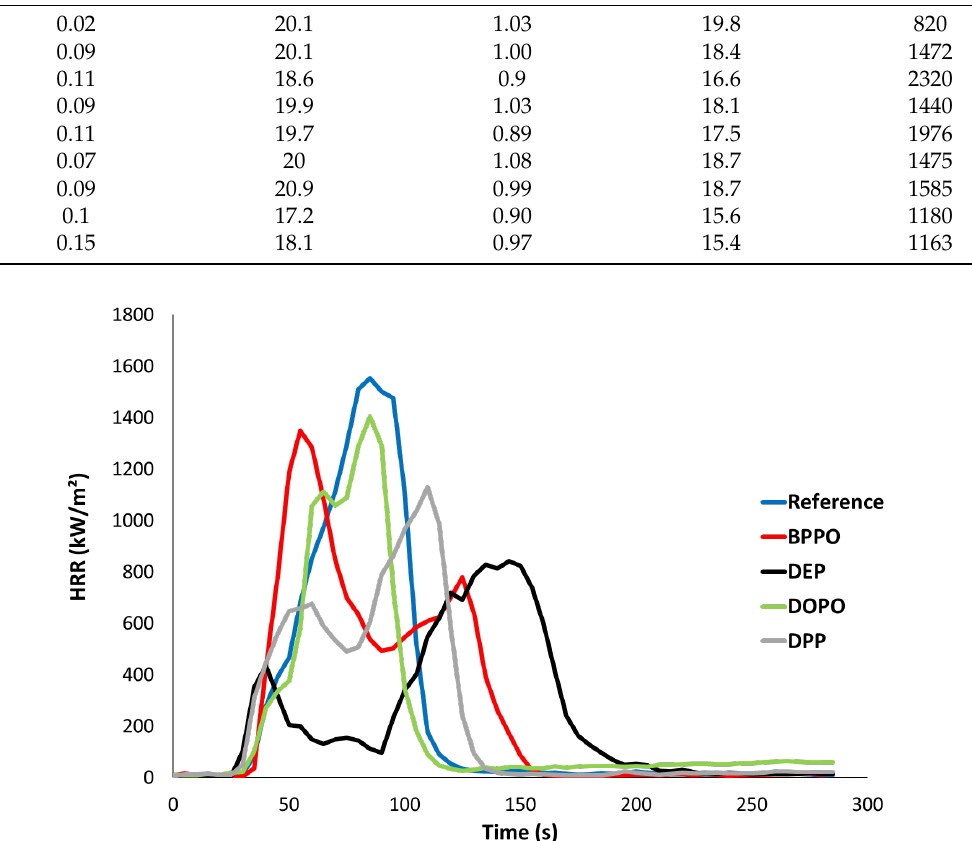
Figure 4. HRR curves in cone calorimeter for reference and PHUs containing 1wt% of phosphorus.